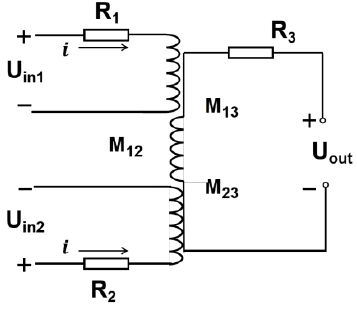
Figure 2. Sensor schematic. Figure 2. Sensor